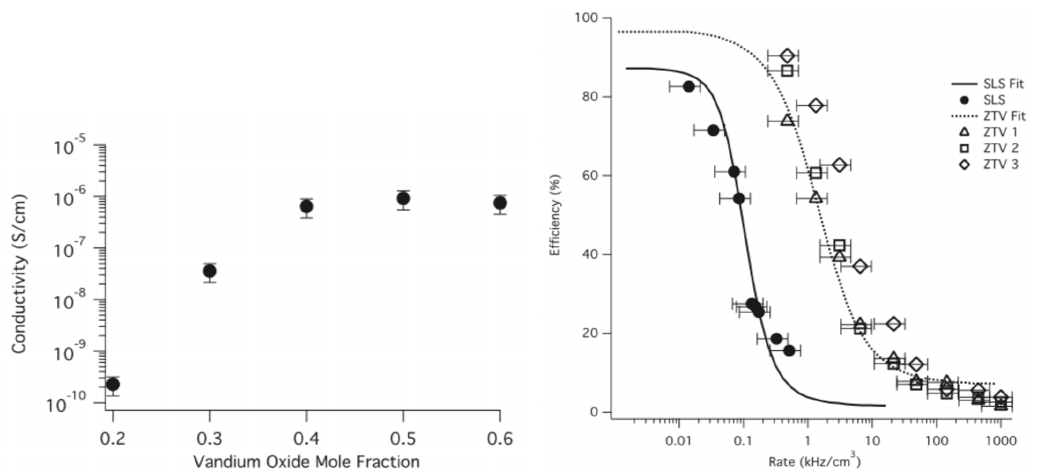
Figure 1. The electronic conductivity of the binary tellurium vanadate glass as a function of the vanadium oxide mole fraction ( left ) and the efficiency vs. particle rate for the RPCs made with zinc-tellurium vanadate glasses ( right